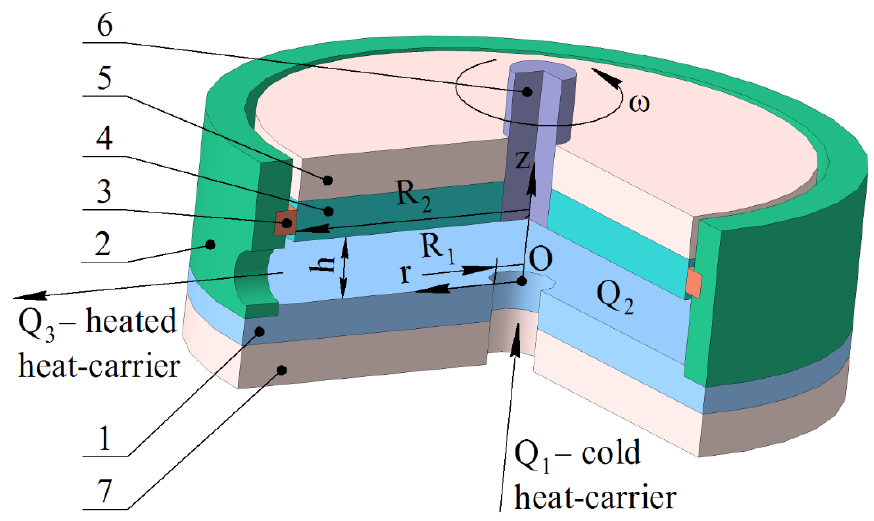
Figure 1. Computational scheme to develop mathematical models: 1–immobile disk; 2–casing 3–sealing component; 4–rotating disk; 5, 7–heat-insulating plates; 6–shaft. The boundary temperature conditions along axis z are conditions along axis r are T ( z , R 1 ) = T n ,